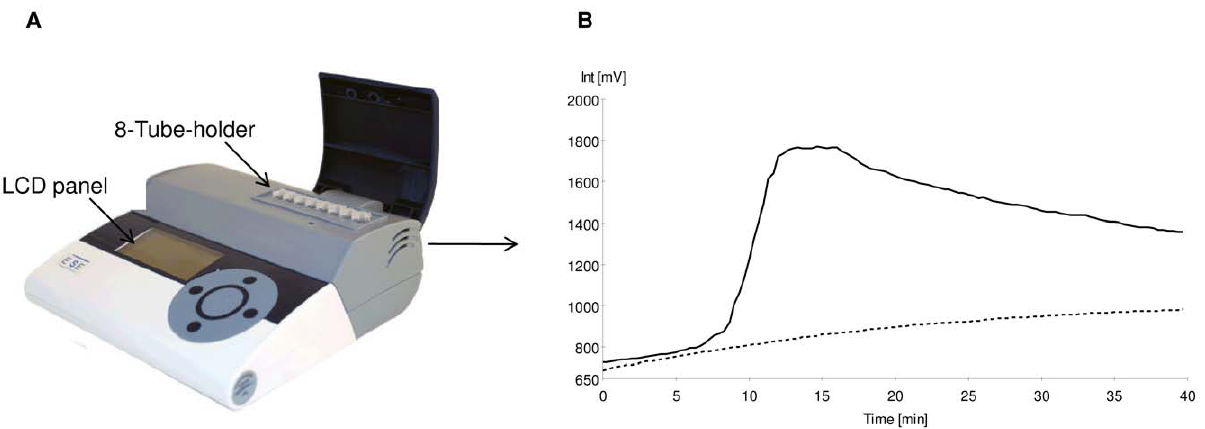
Figure 1. Description of the RealAmp method. The ESE-Quant Tube scanner equipped with temperature settings to amplify DNA isothermally and spectral devices to detect amplified product using fluorescence is shown (A). The tube scanner can hold 8,200 m L PCR tubes and is equipped with an LCD panel through which positive or negative results can be detected. If the tube scanner is connected to a computer with the appropriate software, the results are obtained in real-time as shown in B. The fluorescence units are shown on the Y-axis and the time to amplification on the x- axis. Amplification curves are observed (solid line) in case of a positive sample. No amplification curves (dotted line) indicate a negative sample.